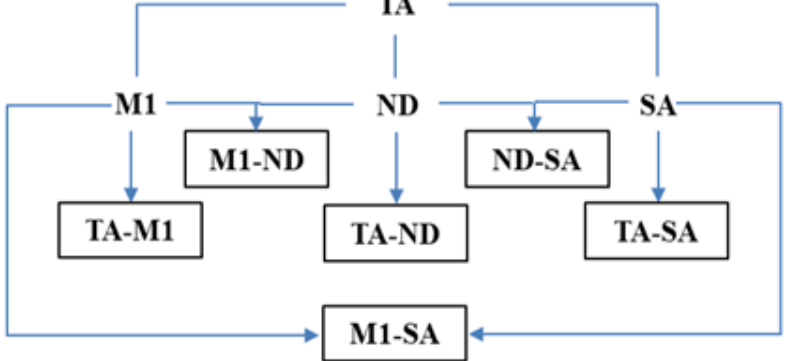
Figure 1. Scheme of lab-scale vinification trials. TA, M1, SA and ND = single fermentations using TA, M1, SA and ND starters, respectively; TA-M1 = co-fermentation with TA and M1 strains; M1-SA = co-fermentation with M1 and SA strains; ND-SA = co-fermentation with ND and SA strains; TA-ND = co-fermentation with TA and ND strains; TA-SA = co-fermentation with TA and SA strains; ND-M1 = co-fermentation with ND and M1 strains.